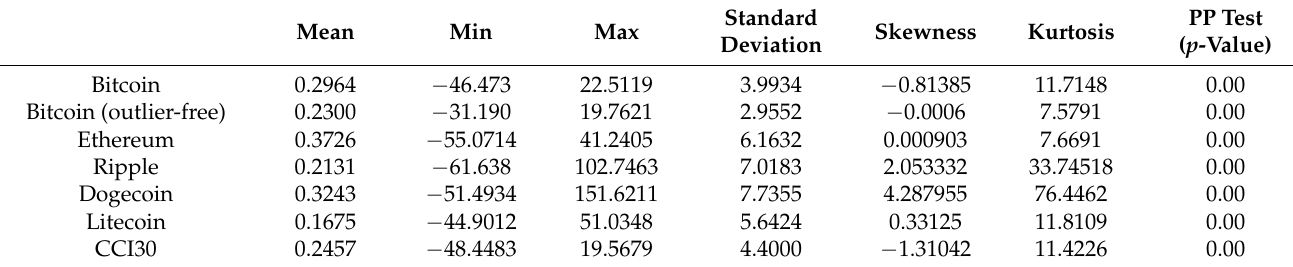
Table 1. Descriptive statistics of daily